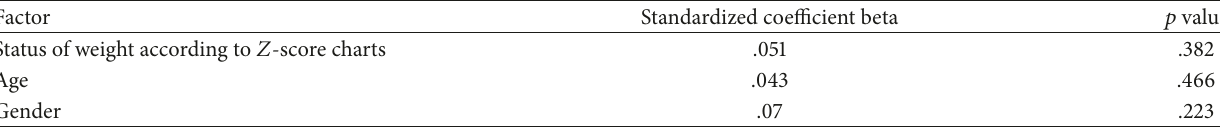
Table 5: Linear regression Model 2. Ferritin as dependent variable and status of weight, age, and gender as independent variables. Factor